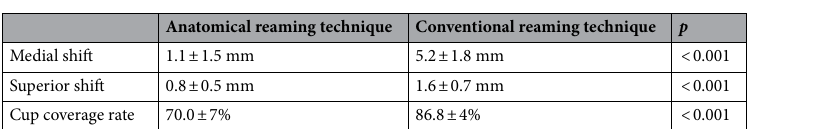
Table 2. Rotation center shift and cup coverage rate with different techniques.